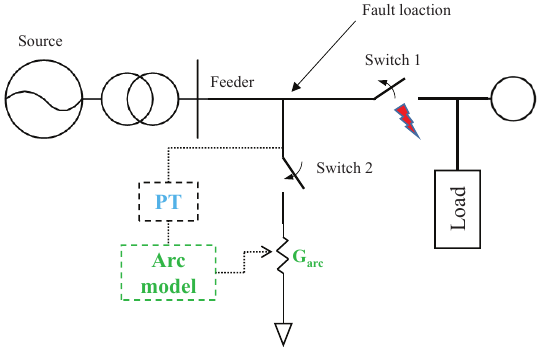
Figure 1. Description for power distribution network in case of fault with arc [6].